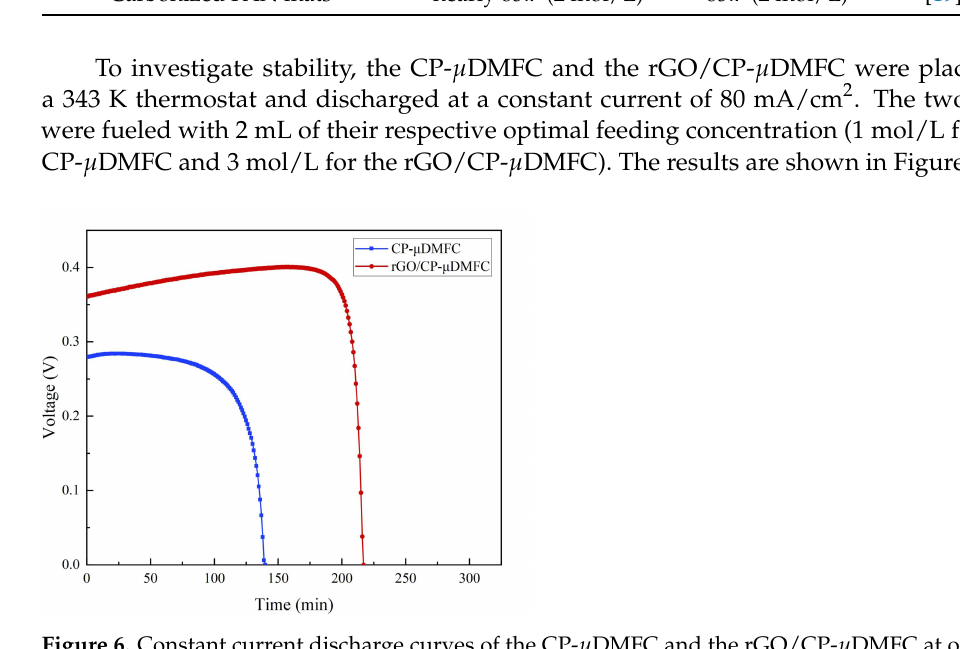
Figure 6. Constant current discharge curves of the CP- µ DMFC and the rGO/CP- µ DMFC at optimal methanol concentrations.